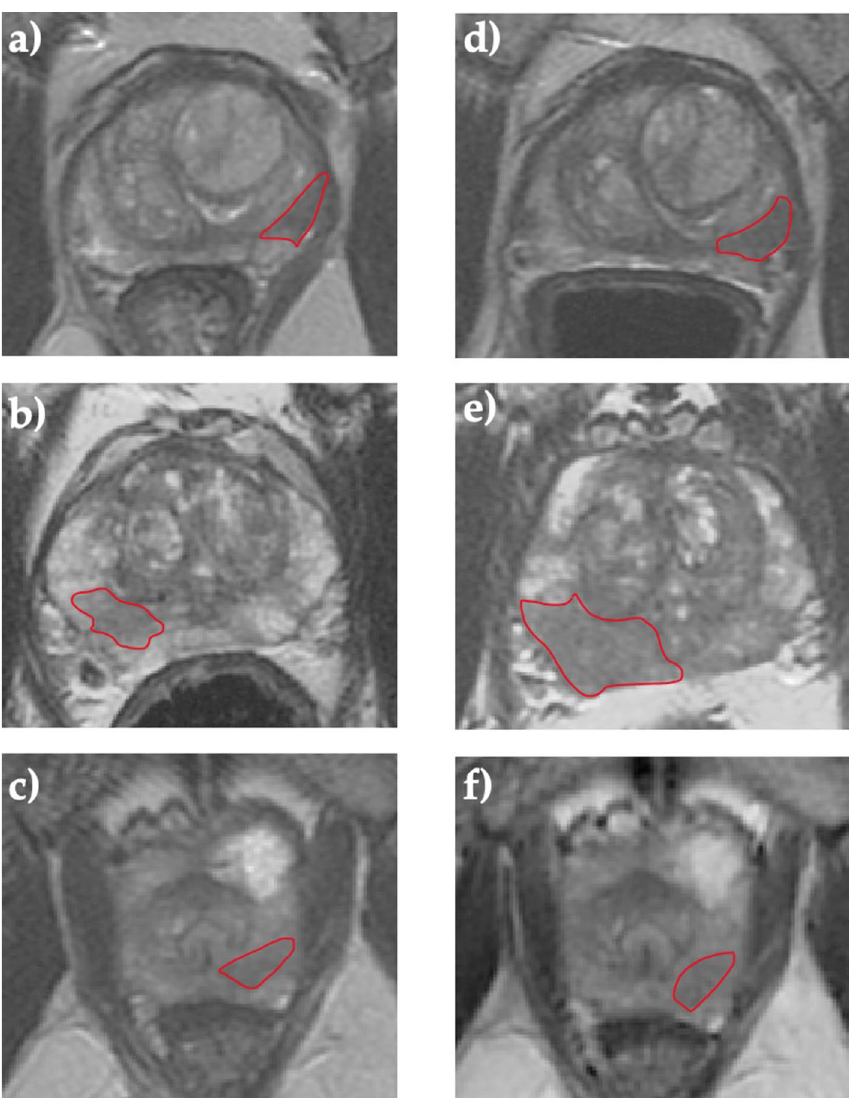
Figure 1. Comparison of T2-weighted images of the prostate obtained at baseline pre-biopsy ( a – c ) and follow-up ( d – f ) mpMRI scans from patients enrolled on active surveillance. Images ( a , d ) were obtained from a patient with stable 3 + 3 = 6 disease that showed neither radiological not histopathological progression over a follow-up period of three years. Images ( b , e ) were obtained from a patient with both radiological (PRECISE 4) and histopathological (3 + 4 = 7 to 4 + 3 = 7) progression. Images ( c , f ) were obtained from a patient with confirmed histopathological progression (3 + 3 = 6 to 3 + 4 = 7) but radiologically stable disease (PRECISE 3). The best-performing predictive model (T2WI-derived radiomic features, PSA and PSA density) predicted the clinical outcome in all three presented